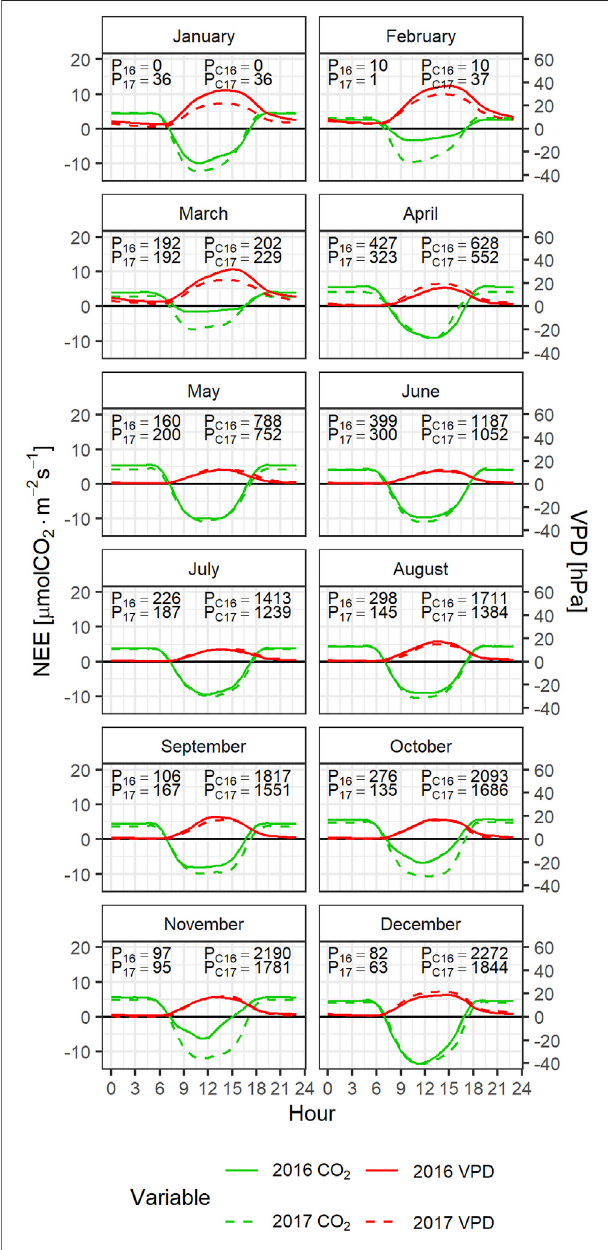
FIGURE 5 | Mean daily pro fi le of CO 2 fl uxes and VPD by month during 2016 (red) and 2017 (green). Each panel shows the monthly precipitation during each year (P 16 for 2016 and P 17 for 2017) and the accumulated precipitation from January to each month (P C16 and P C17 ).